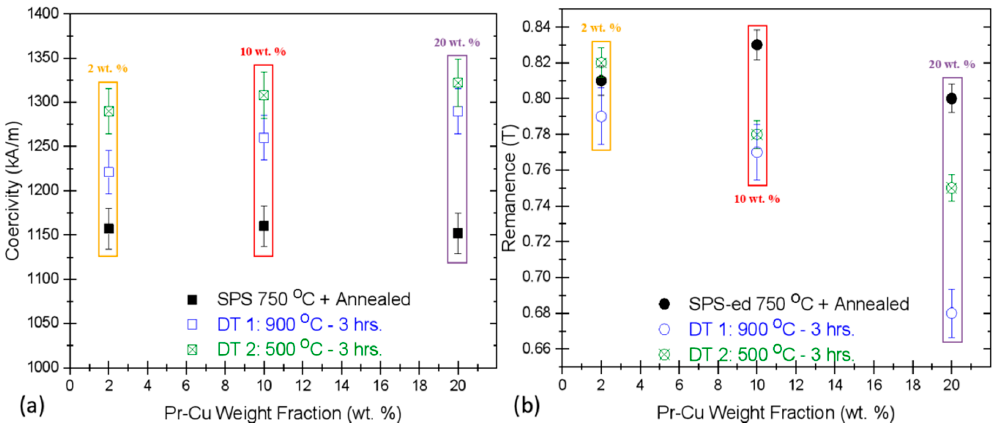
Figure 2. The variation of ( a ) coercivity ( H Ci ) and ( b ) remanence ( B r ) after GBD treatment with different wt. % Pr 68 Cu 32 alloy ribbons. Plots legend: yellow 2 wt. %, red 10 wt. % and purple 20 wt. % Pr-Cu as the diffusion source on bulk HDDR Nd-Fe-B SPS-ed magnets (RM).